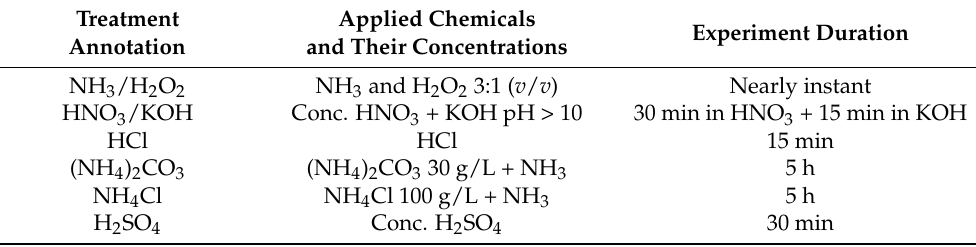
Table 1. Applied chemicals, concentrations and experiment durations of fibers surface